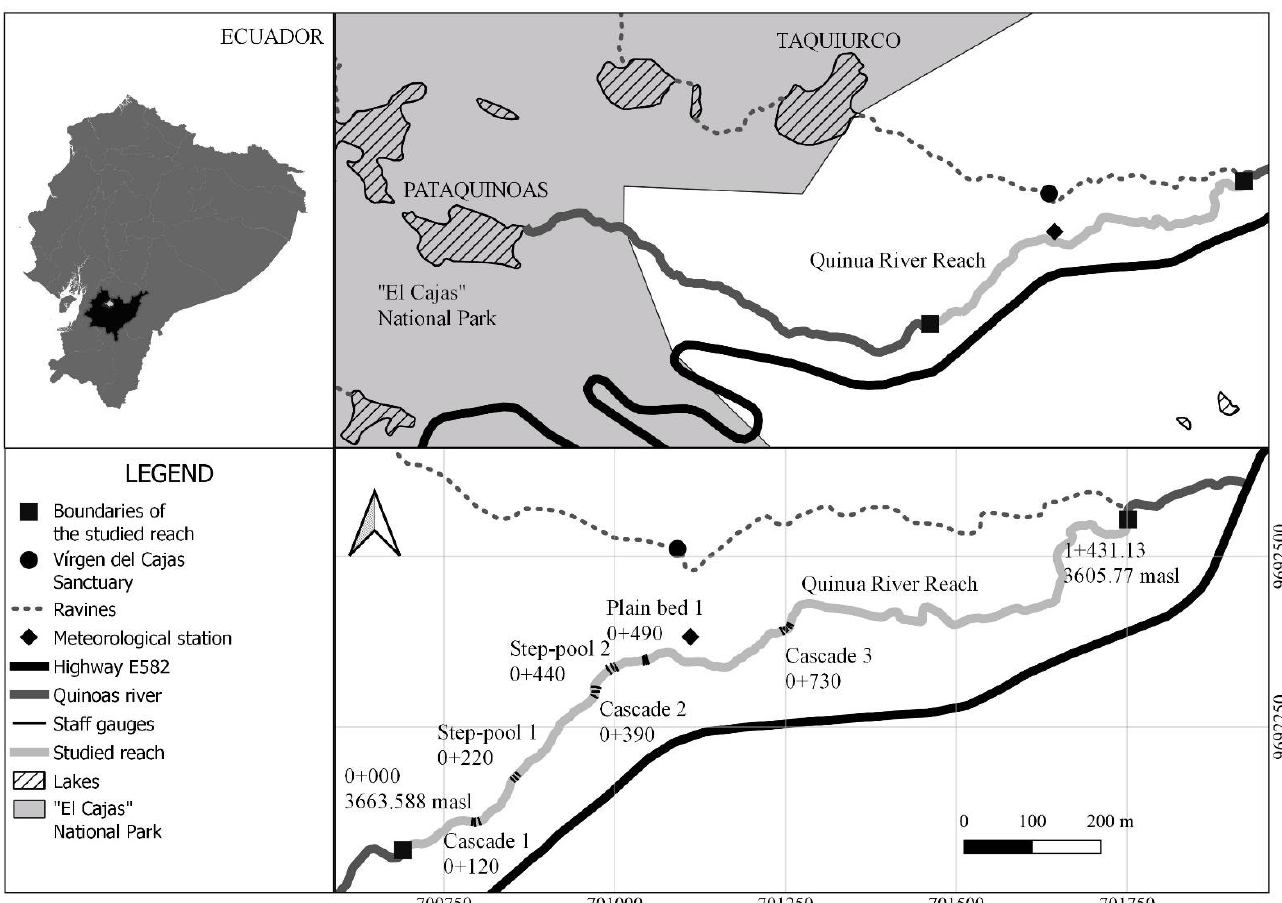
Figure 1. Location of the 1.5 km river reach with indication of the different morphologies.